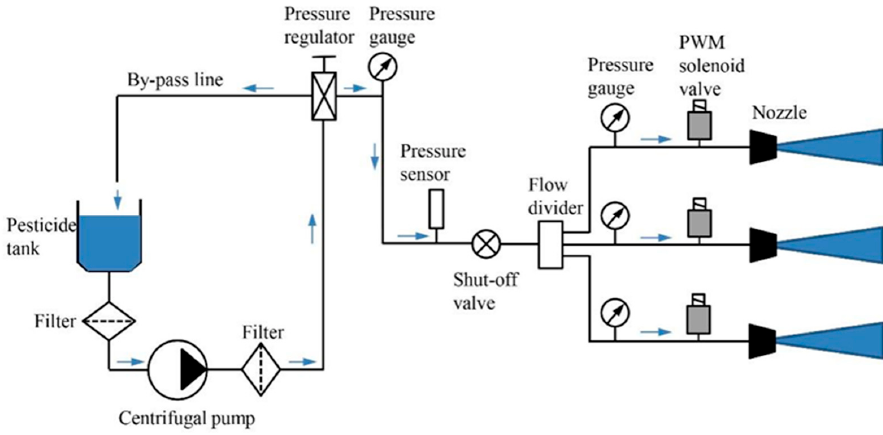
Figure 5. Schematic diagram of the variable rate spraying system.